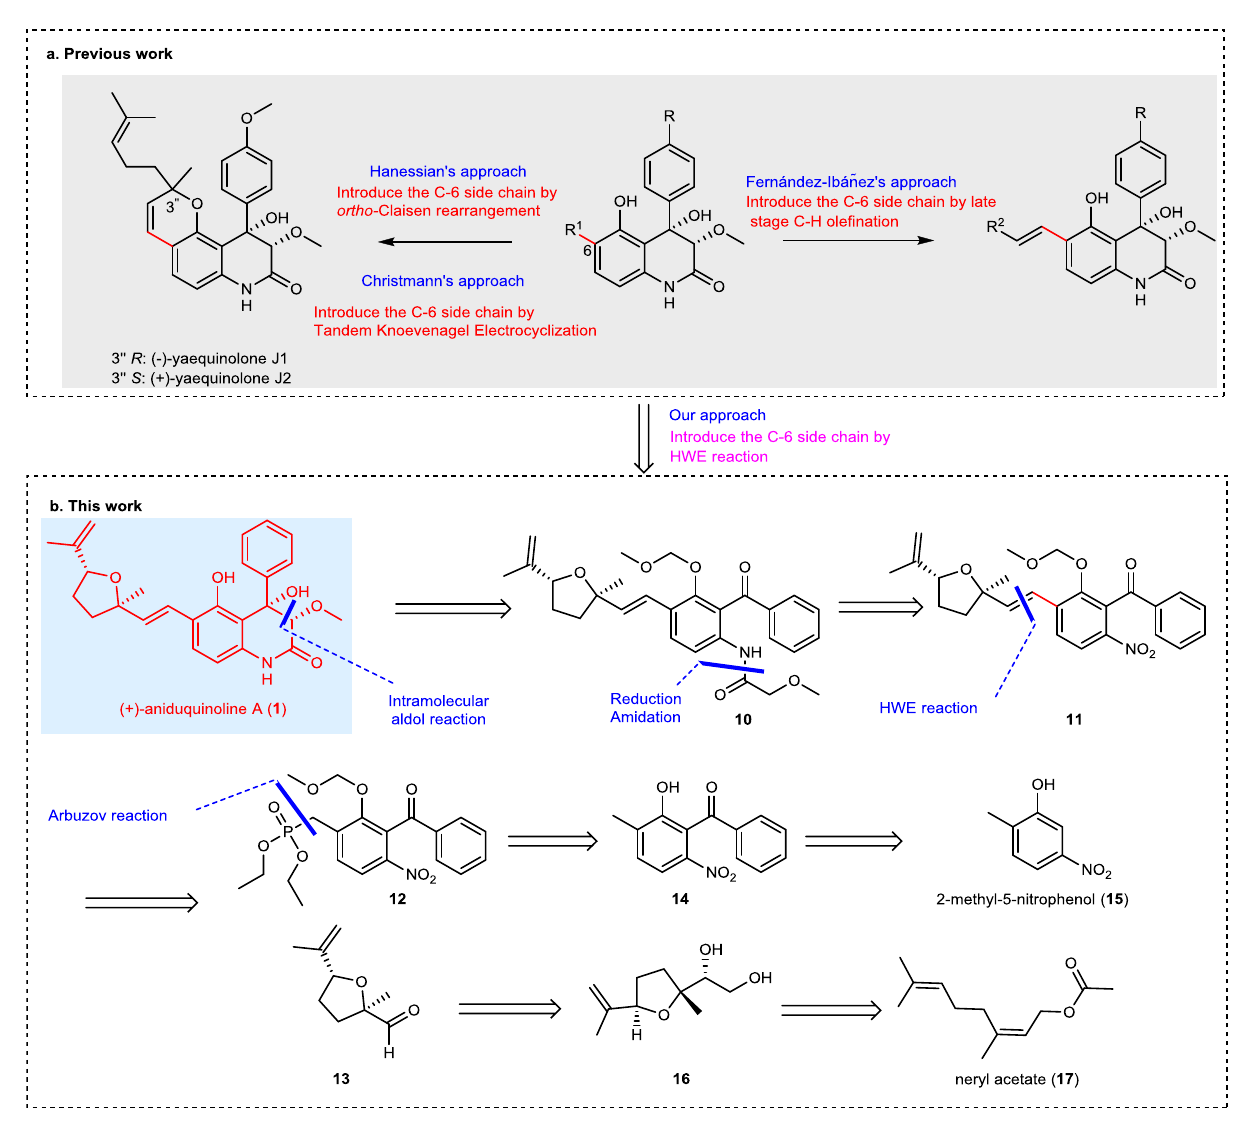
Fig. 2 Synthetic strategy. a Previous synthetic routes of the 3,4-dioxygenated 5-hydroxy-4-aryl-quinolin-2(1 H )-one containing alkaloids. b Retrosynthesis of ( + )-aniduquinolone A ( 1